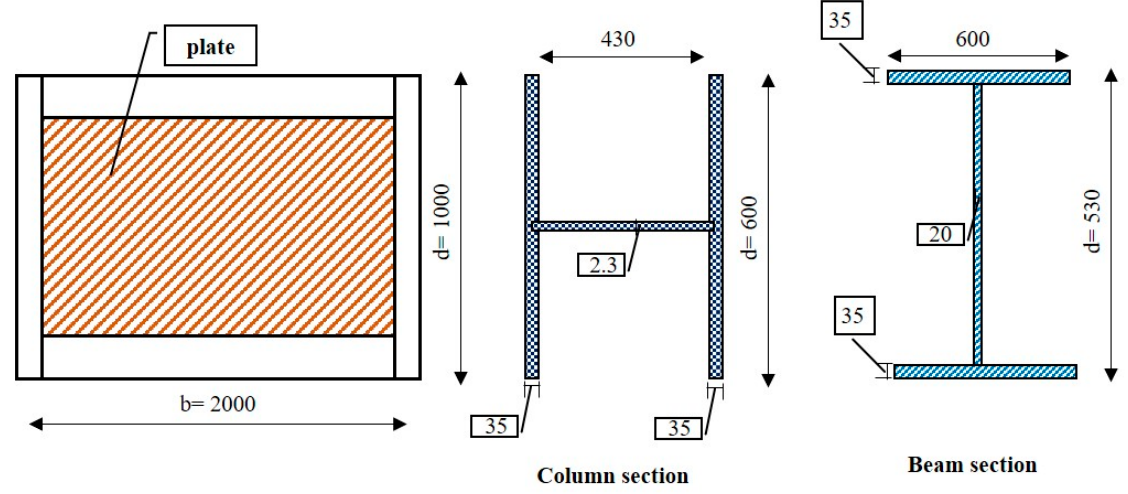
Figure 2. Experimental specimen dimensions. Table 1. Details of the experimental specimens and their mechanical properties.